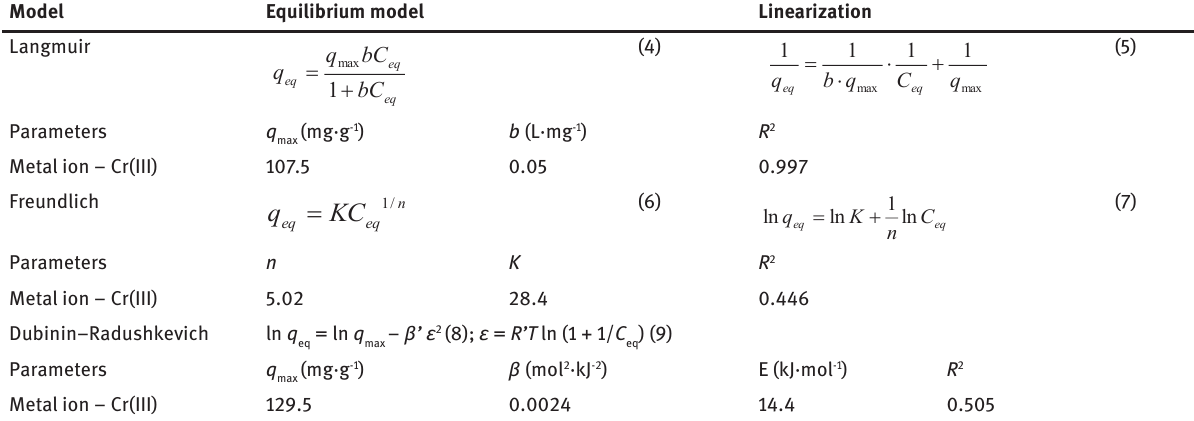
Table 2. The parameters obtained from Langmuir, Freundlich and Dubinin-Radushkevich models.